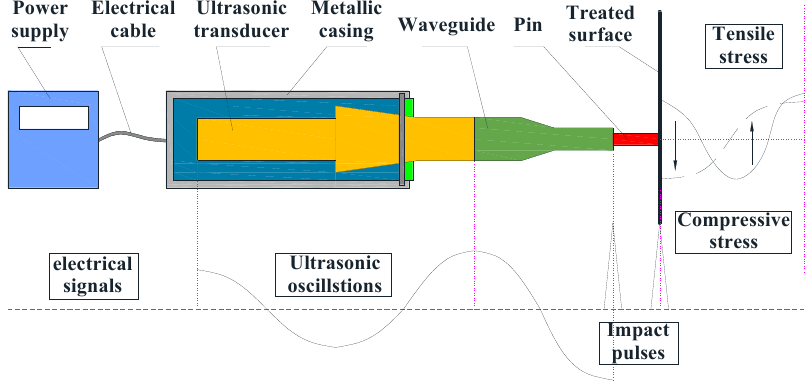
Figure 5. Schematic diagram of ultrasonic impact treatment (UIT). Materials 2020 , 13 , x FOR PEER REVIEW